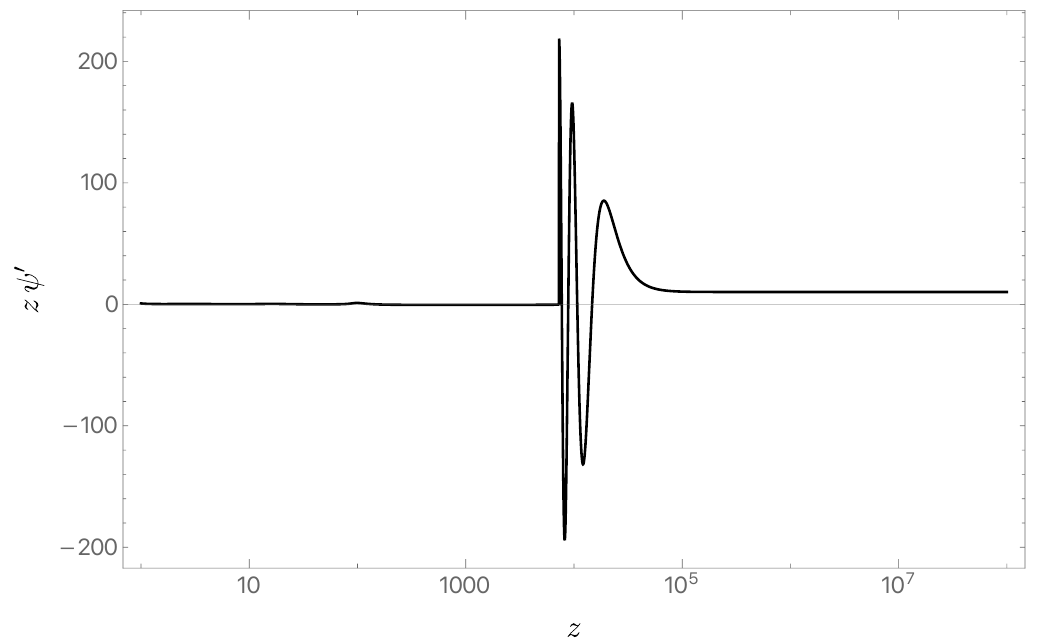
Figure 7 . Details of a Kasner transition that is not described by (4.23) and where a fine tuned choice of parameters ( α = 1 , q = 0 . 5 m, mM = 1 . 0 and Q/Q c − 1 = 2 . 361775783 × 10 − 3 ) shows that we can have Kasner transitions that are immediately followed by a ‘second’ Josephson oscillations phase. One has β = − 0 . 427266 and β new = 1 . 01622